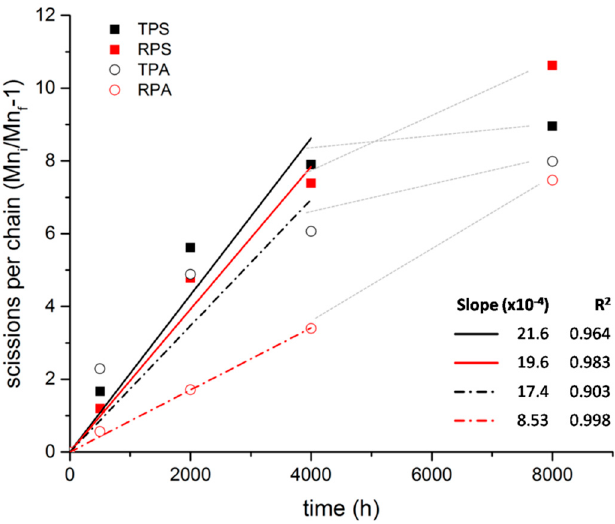
Figure 7. Scissions per chain of reference samples as a function of irradiation time and respective linear fit for 0–4000 h; gray lines indicate an inflection on the evolution with time.